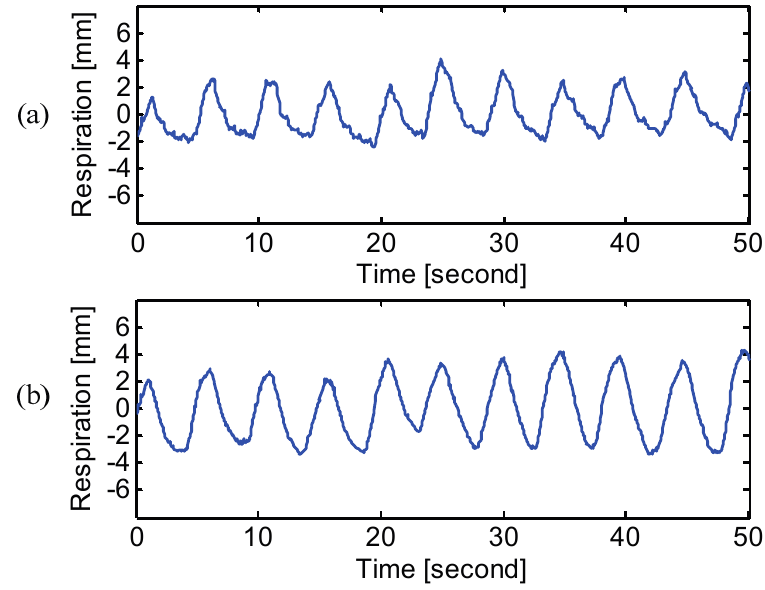
Figure 5. Radar measured signals at ( a ) chest and ( b ) abdomen when the subject was performing natural breathing.